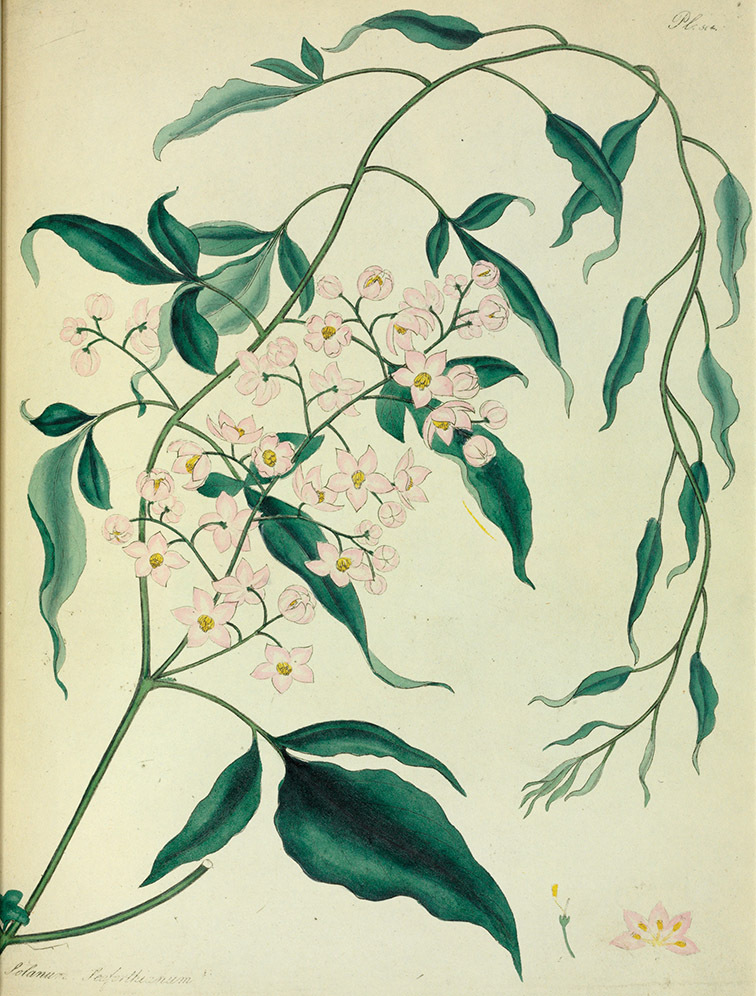
Lectotype of Solanum seaforthianum Andrews (Andrews 1808: tab. 504) Reproduced with permission of the Natural History Museum Botany Library.